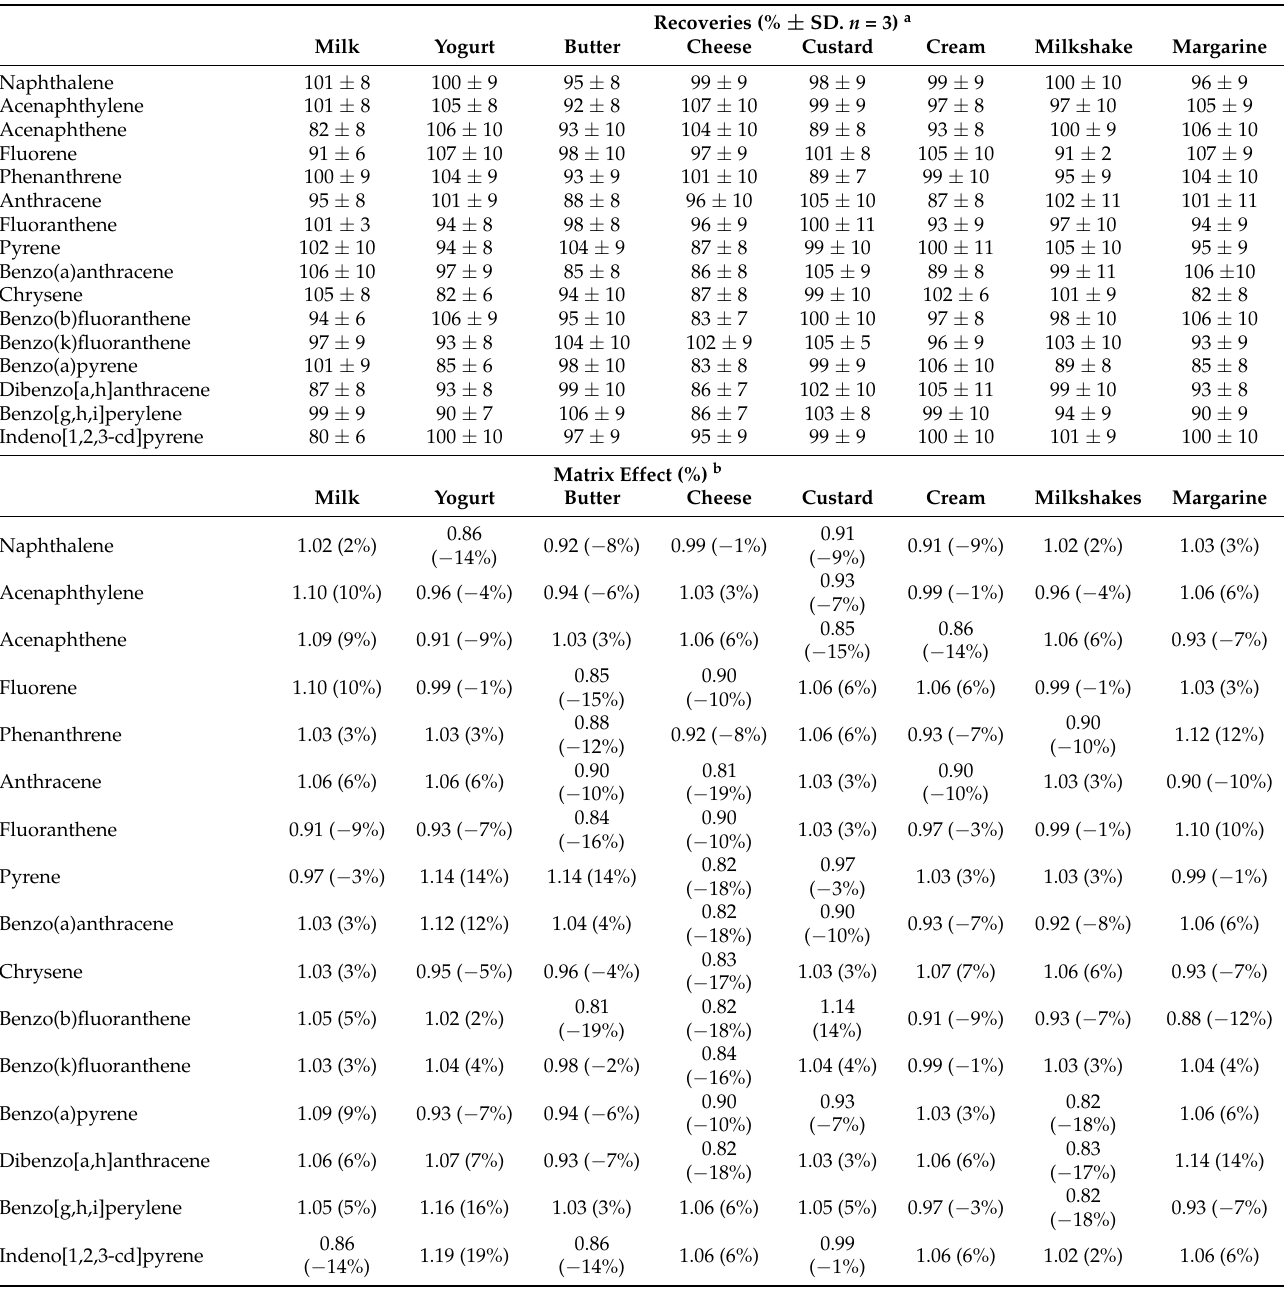
Table 3. Results obtained in the recovery and matrix effect studies of the different types of milk and dairy product